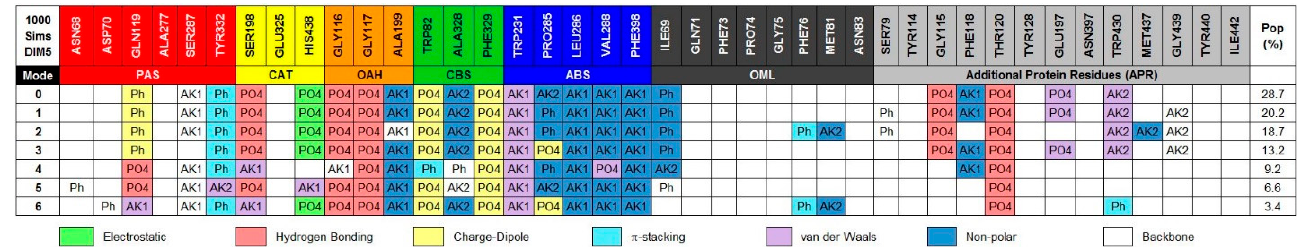
Figure 6. Contact table for the DIM5 inhibitor in BChE binding pocket. SWIFs were taken post 80 ns from one thousand 110 ns MD simulations [148].